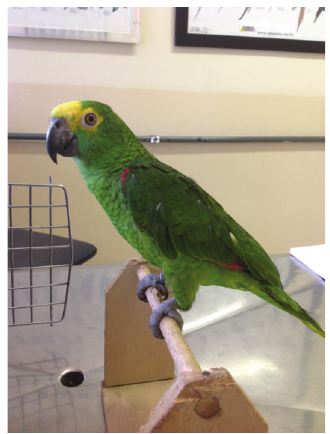
Figure 2: Blue Fronted Amazon parrot six months after the clinical presentation, with no clinical